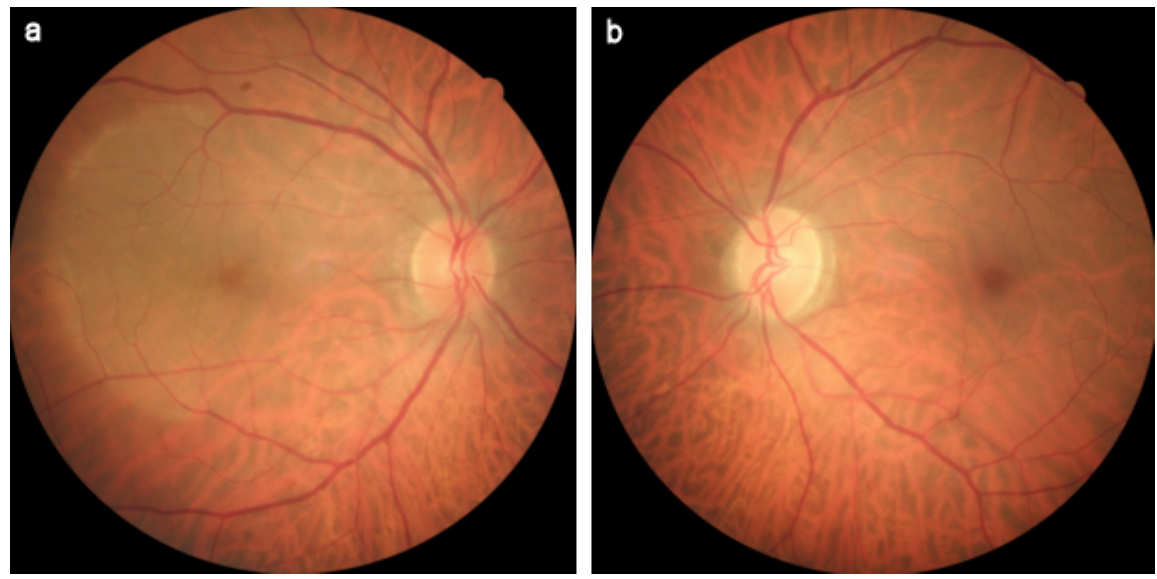
Figure 1: Fundus images at the time of diagnosis (a) Fundus appearance of the AZOOR lesion as an annular ring of yellowish reflex with an about 4–5 disc diameter in the right eye, (b) fundus photo showing the normal left eye